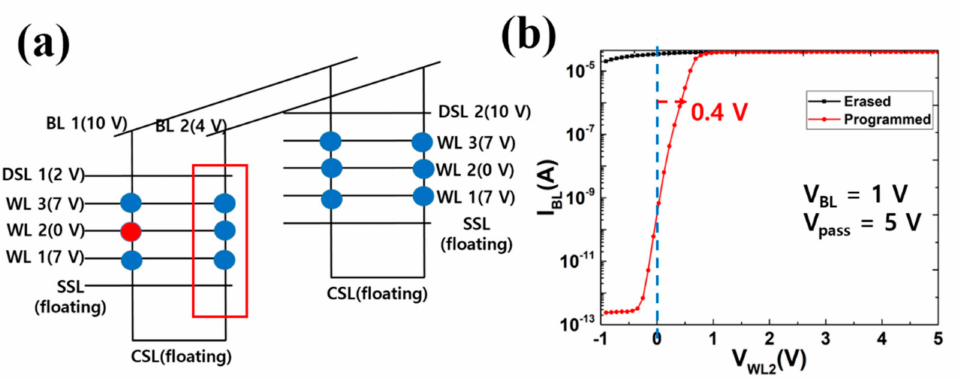
Figure 8. Memory simulation results for program operation: ( a ) program operation voltage and ( b ) operation